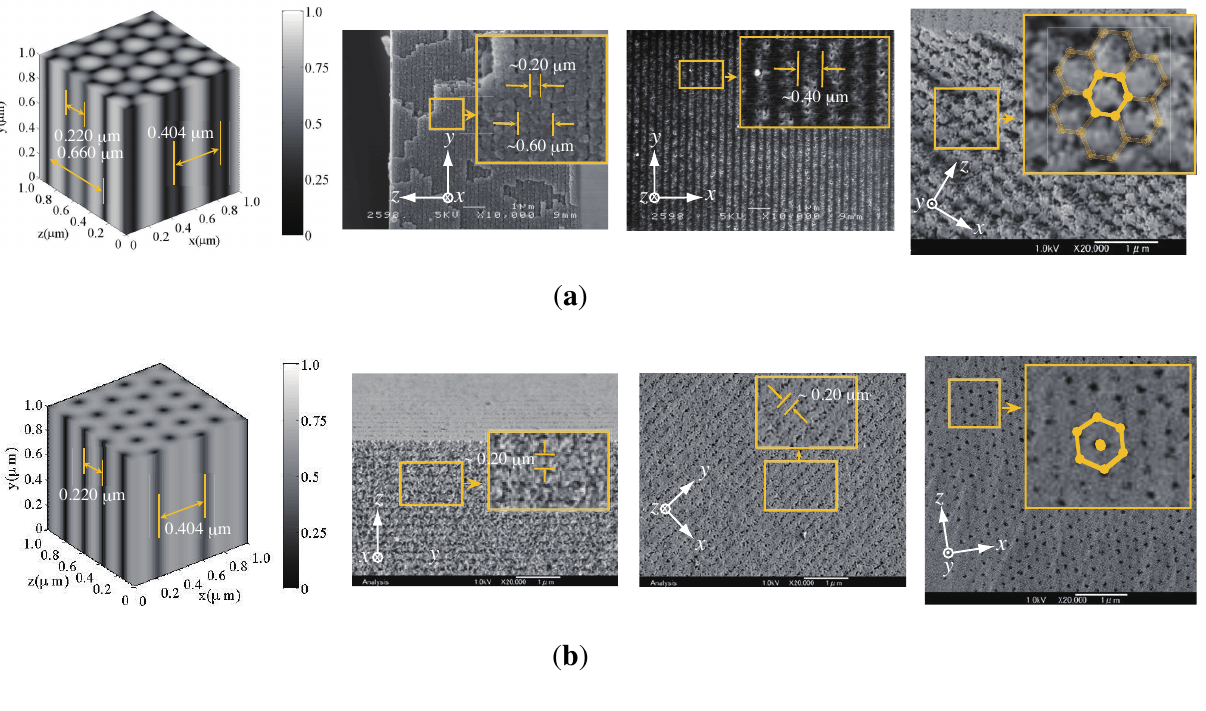
Figure 8. 3D polymer structures for HPDLC films under three-beam interference holographic polymerization by using three ( a ) s- and ( b ) p-polarized plane waves. Calculated 3D polymer distributions in volume fraction, cross sectional SEM images in the y - z , x - y and x - z planes are shown in order from the left in ( a ) and ( b ).